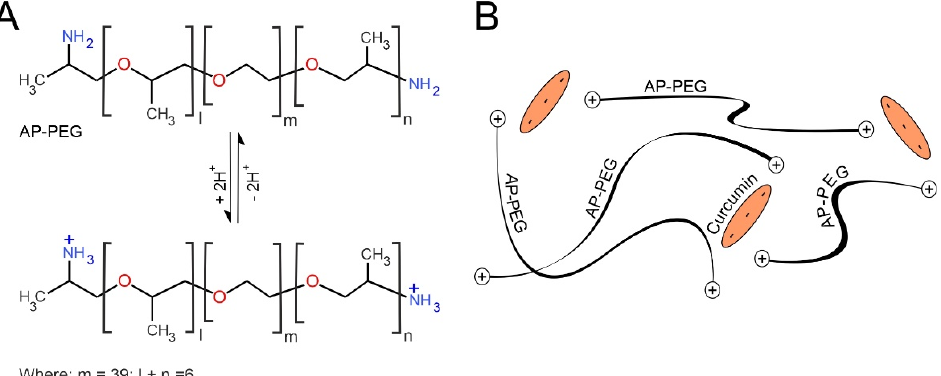
Figure 11. ( A ) Acid–base characteristics of O , O ′ -bis(2-aminopropyl) polypropylene glycol– block – polyethylene glycol– block –polypropylene glycol (AP-PEG) and ( B ) its complexation of curcumin within a polymer network.